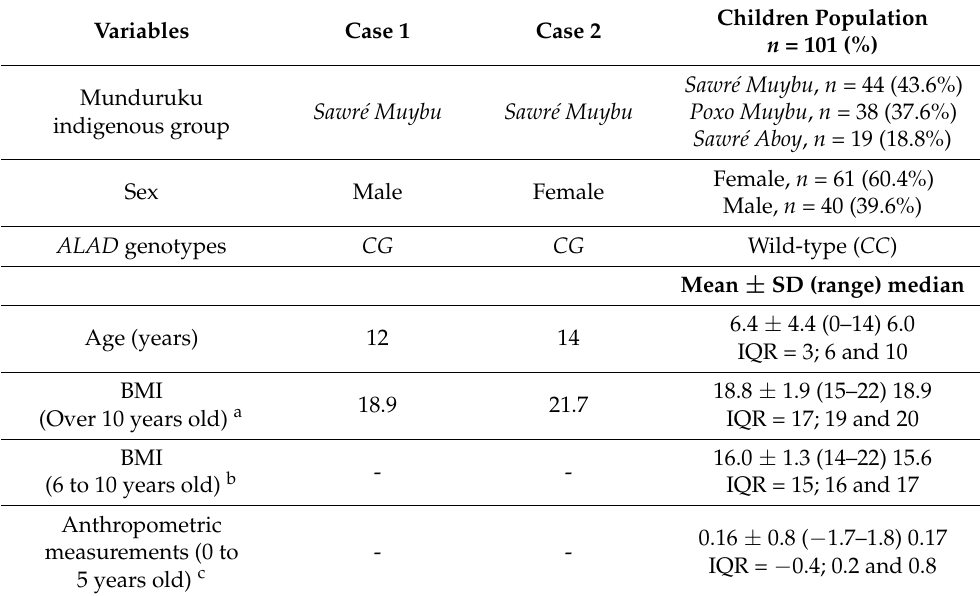
Table 1. Epidemiological features and ALAD genotypes of the study population ( n = 103), Sawr é Muybu Indigenous Land, Par á , Amazon, Brazil, 2019. Variables Case 1 Case